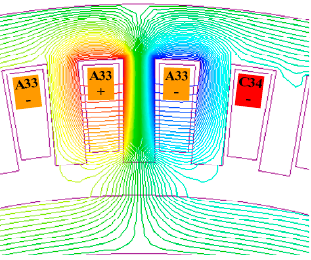
Figure 2. The armature flux linkage of A34.